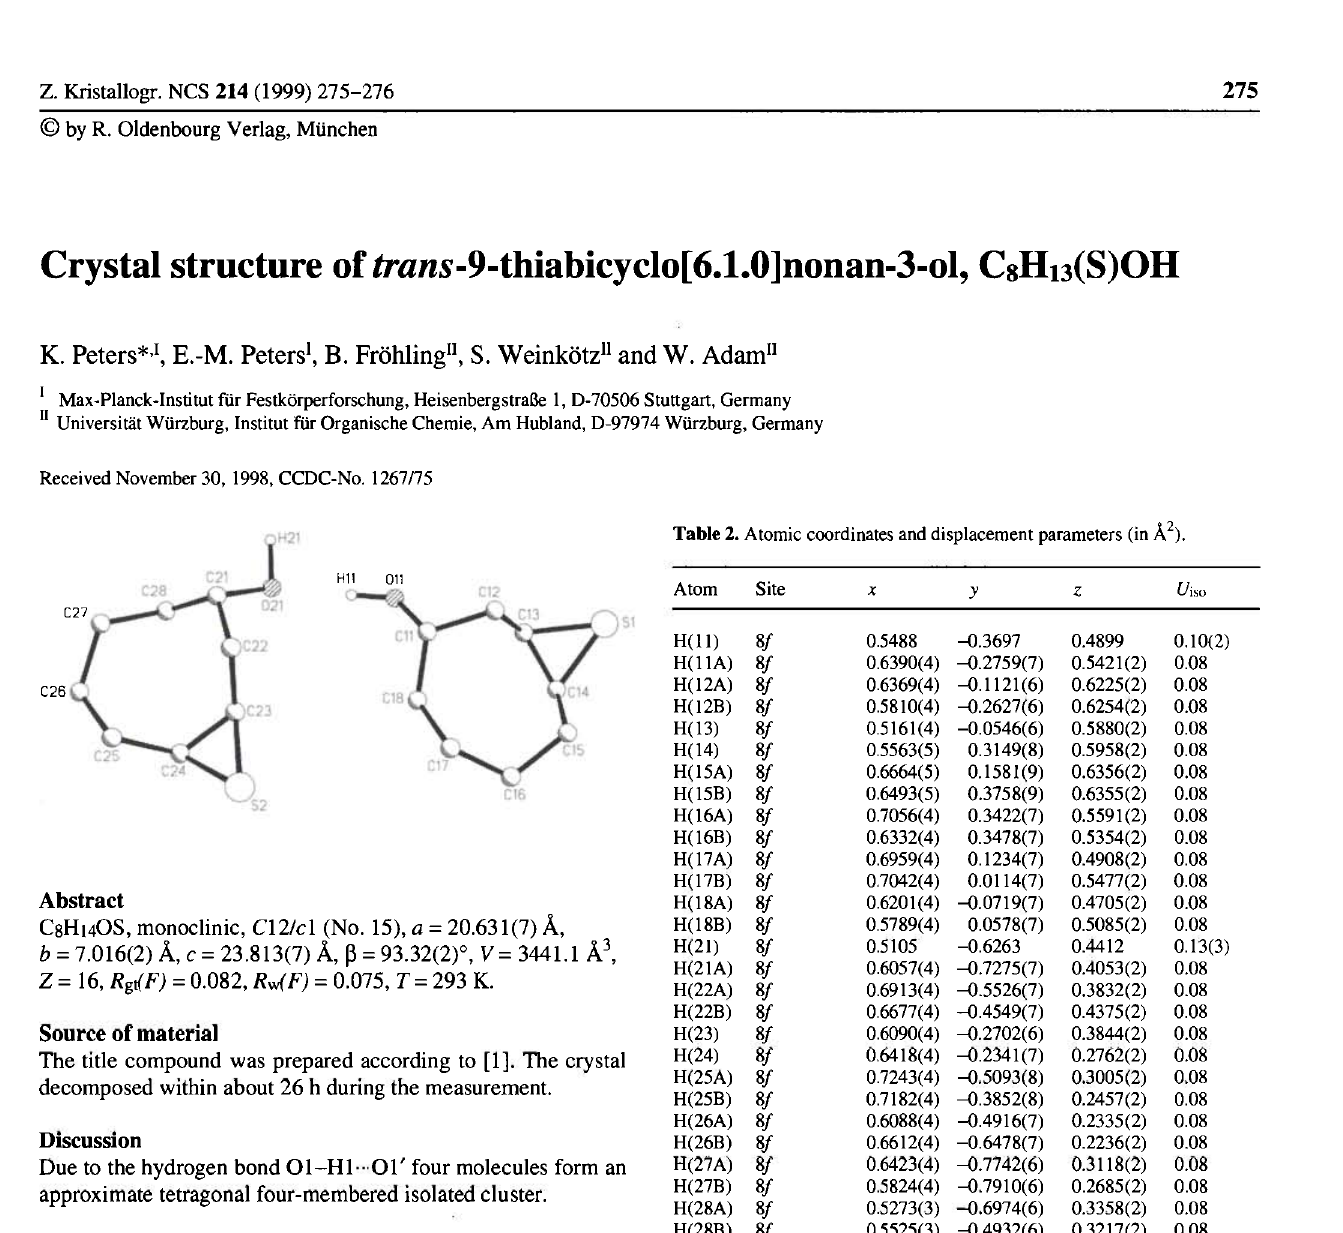
Table X. Data collection and handling.